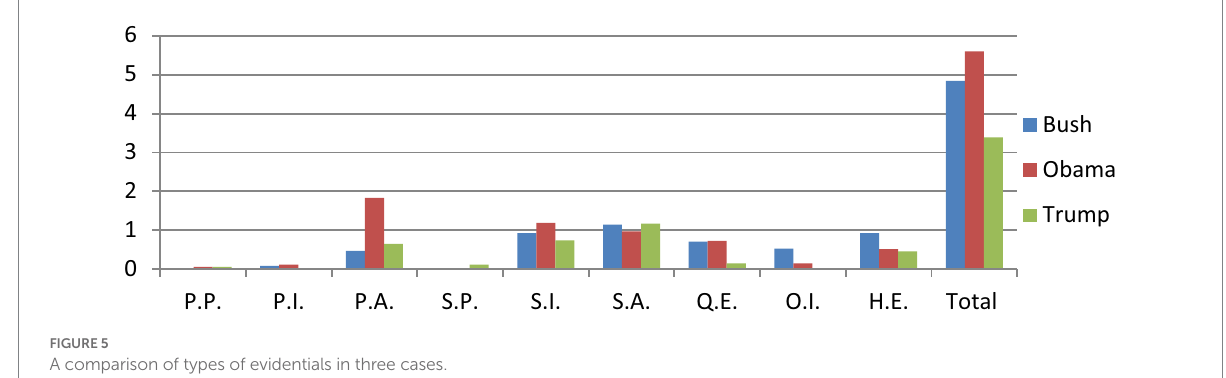
FIGURE 5 A comparison of types of evidentials in three cases.